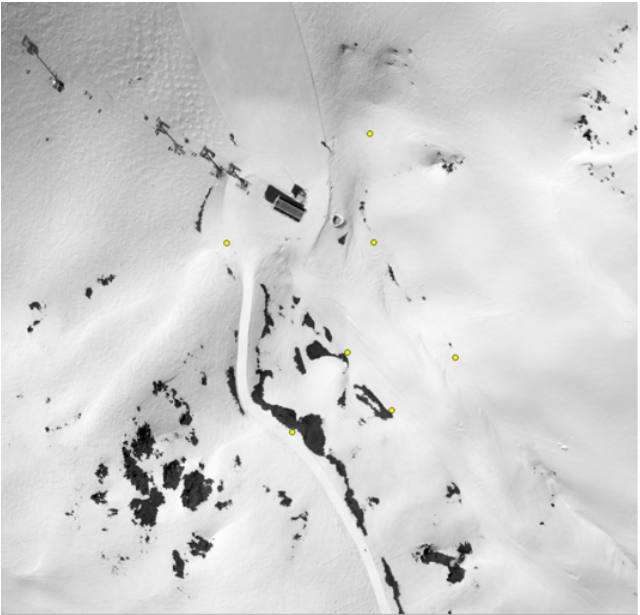
Figure 3. Orthoimage "Brämabühl" with 7 GCP points (yellow) Both UAV flights (Table 1) have been processed using PhotoScan Professional v1.2.4 (PHS) and for the absolute orientation 7 ground control points (GCPs) have been used, which had to be positioned within the flatter part of the test